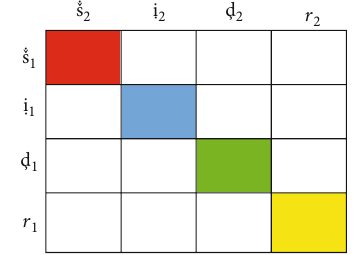
Figure 2: Geometrical description of the suggested